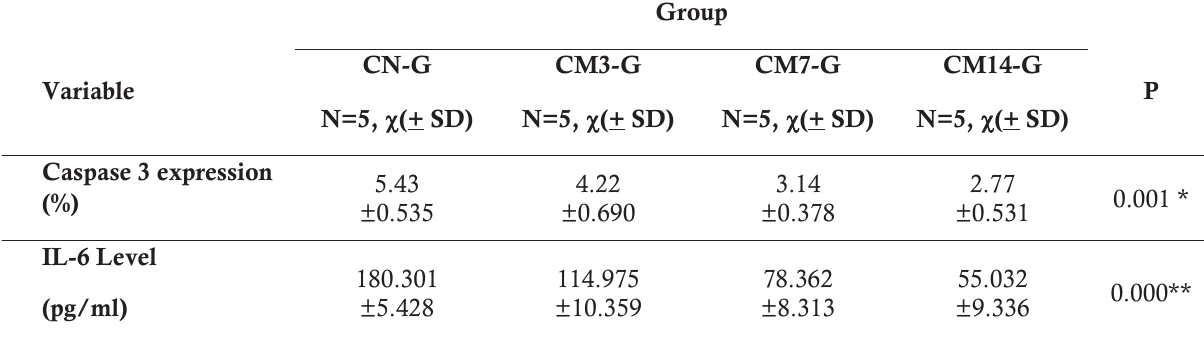
Table 1. Average IL-6 levels and caspase 3 expressions of hepatocytes in each Group